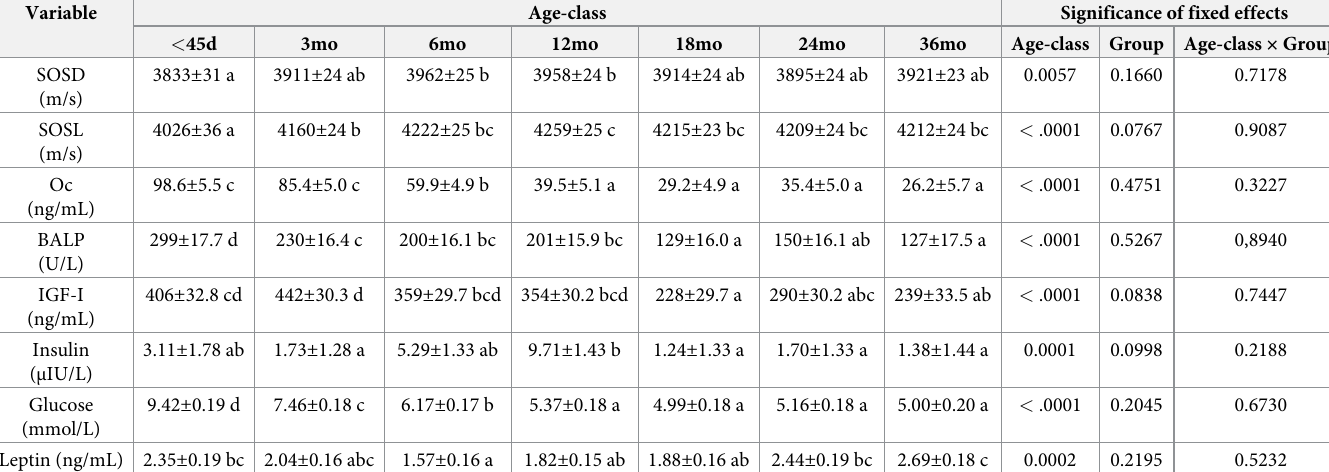
Table 5. Speed of sound measurements and plasmatic concentrations of osteocalcin, bone alkaline phosphatase, insulin-like growth factor I, leptin, insulin and glu- cose of Lusitano horses (n = 24 � ) from birth to 36 months of age according to the radiographic status.